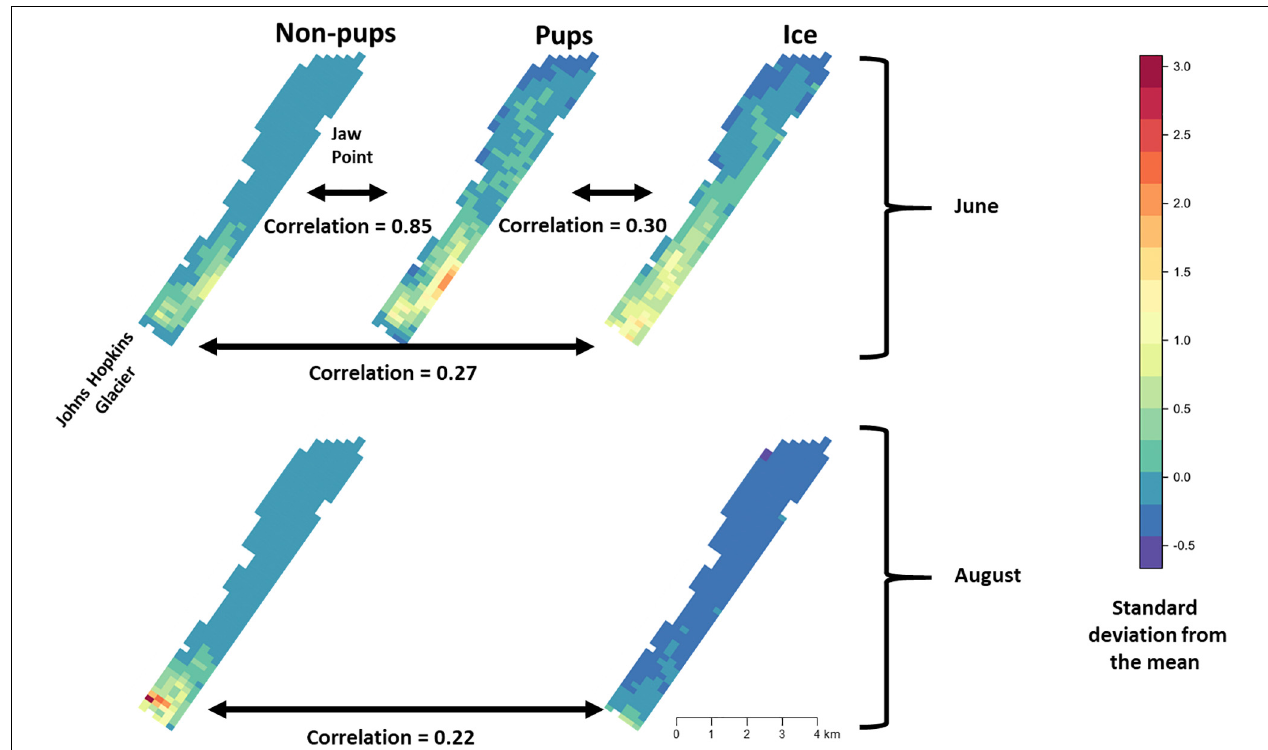
FIGURE 10 | Average density and correlation among harbor seal non-pups, harbor seal pups, and ice during the pupping period in June (top), molting in August (bottom) in Johns Hopkins Inlet in Glacier Bay National Park in southeastern Alaska. The colors and estimates depict the posterior mean of the average values for years 2007–2014. The posterior distributions of average values were derived using the equivariance property of Markov chain Monte Carlo. Correlation values can range from –1 to 1. Grid cell size is 200 m × 300